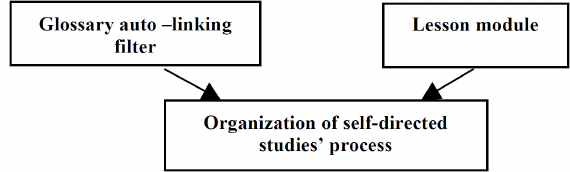
Figure 11. Moodle’s tools for organization of self-directed studies’